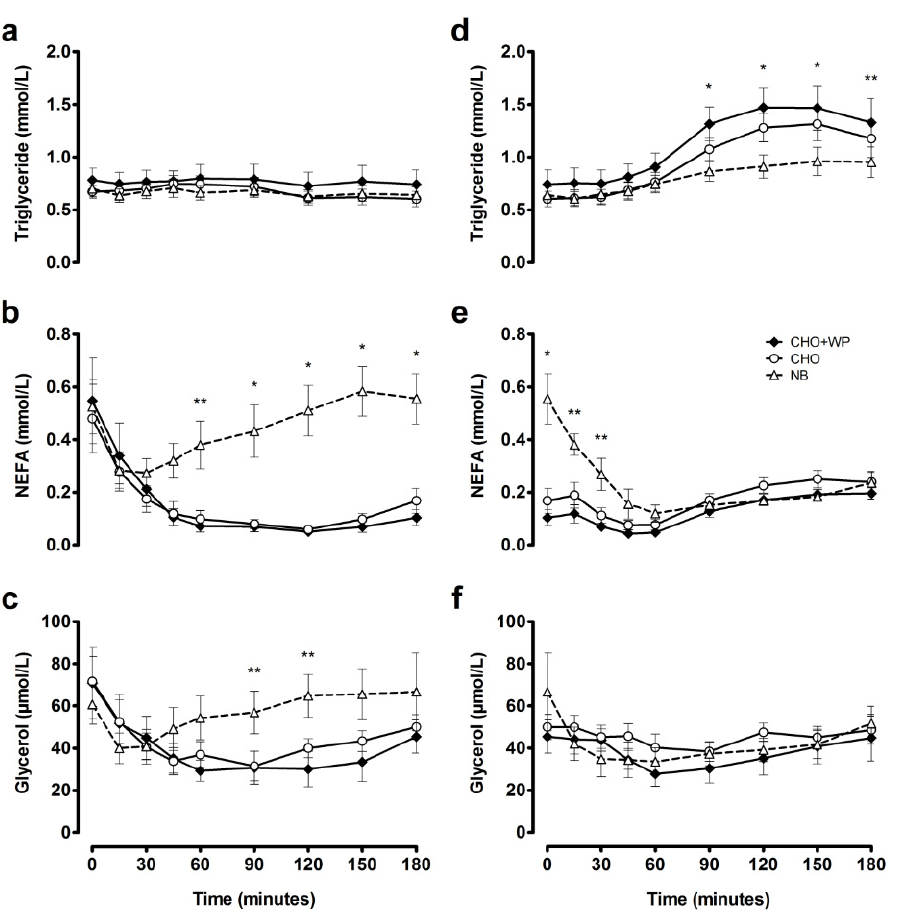
Figure 3. Mean ± SEM temporal changes in plasma triglyceride ( a ); NEFA ( b ) and glycerol ( c ) during the post ‐ breakfast period, and plasma triglyceride ( d ); NEFA ( e ) and glycerol ( f ) during the post ‐ lunch period. Significant differences ( p < 0.05) between trials at individual time points are defined as follows: * NB vs. CHO + WP and CHO, ** NB vs. CHO + WP. CHO: high ‐ carbohydrate